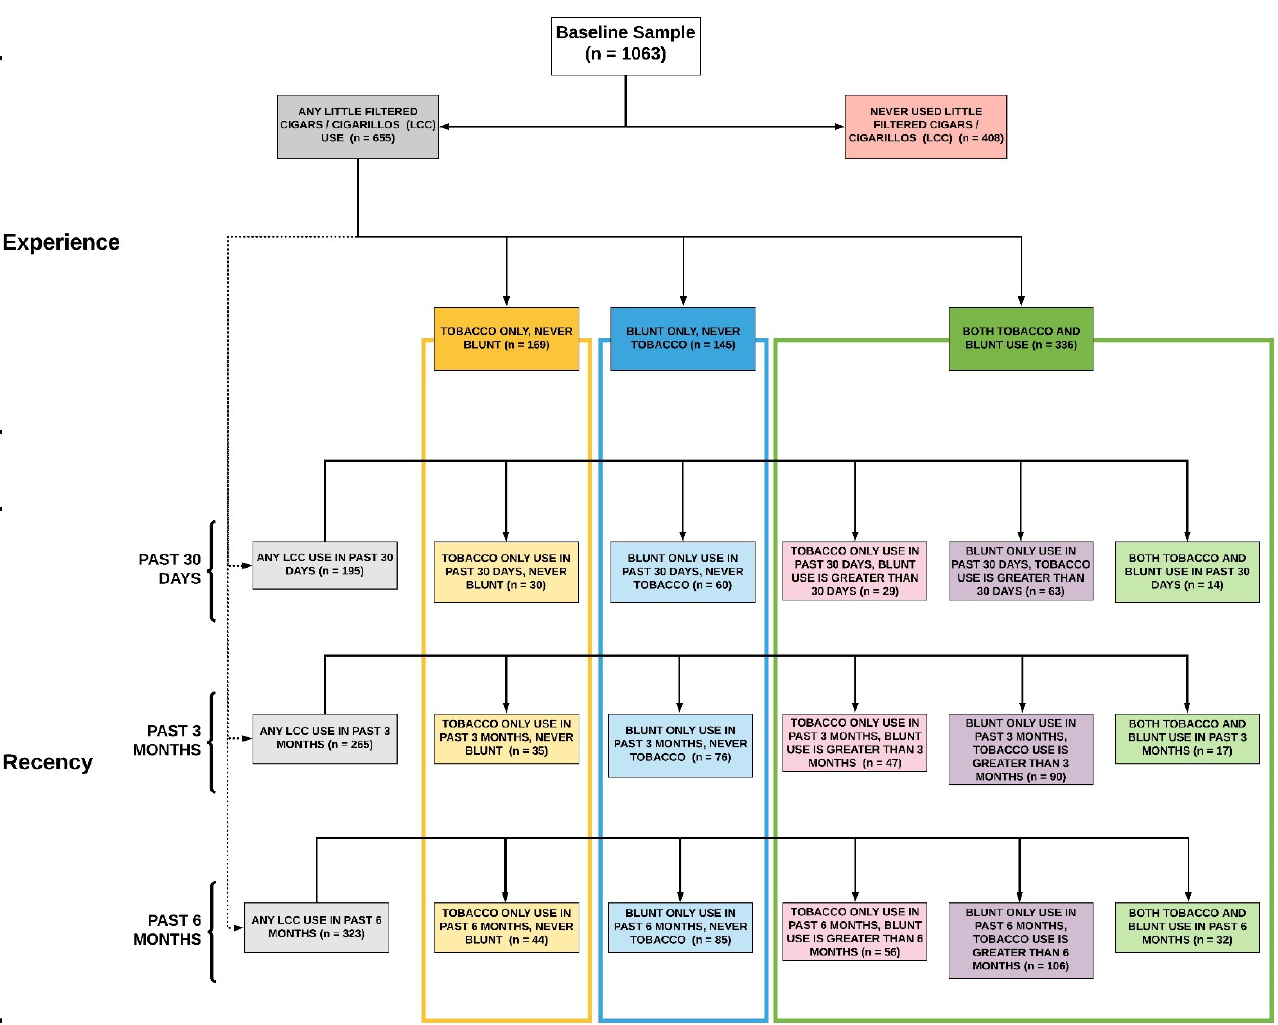
Figure 2. LCC Use Heterogeneity: Modality and Timing of Last Use.